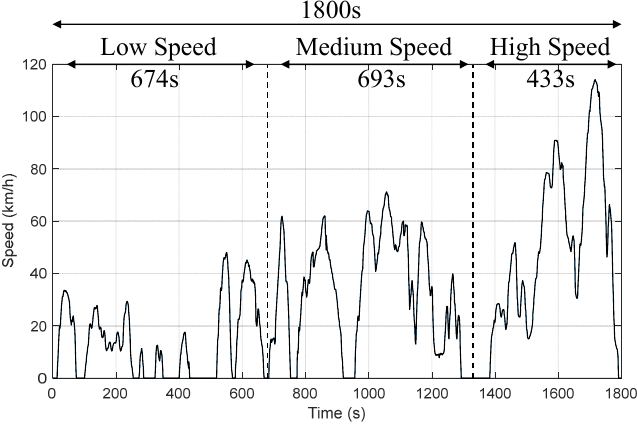
Figure 6. Profile of CLTC-P drive cycle. Table 4. Key Parameters of the